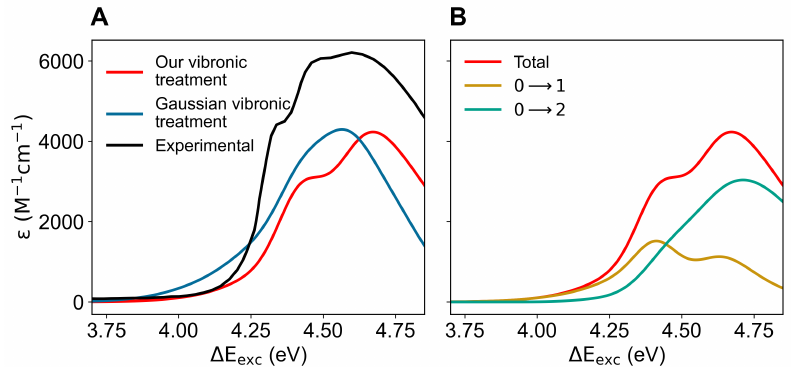
Figure 5. ( A ): Calculated (colored) and measured (black; adapted from Hilaire et al. [53]) absorption spectra of indole in aqueous solution. The predicted spectra were obtained using our vibronic treat- ment (red) and with the vibronic structure calculated using the algorithms implemented in Gaussian (blue), both as provided by the ground-state MD ensemble. ( B ): Calculated total absorption spectrum (using our vibronic treatment) of indole in aqueous solution and the corresponding contributions to the vibronic spectrum due to the first two electronic